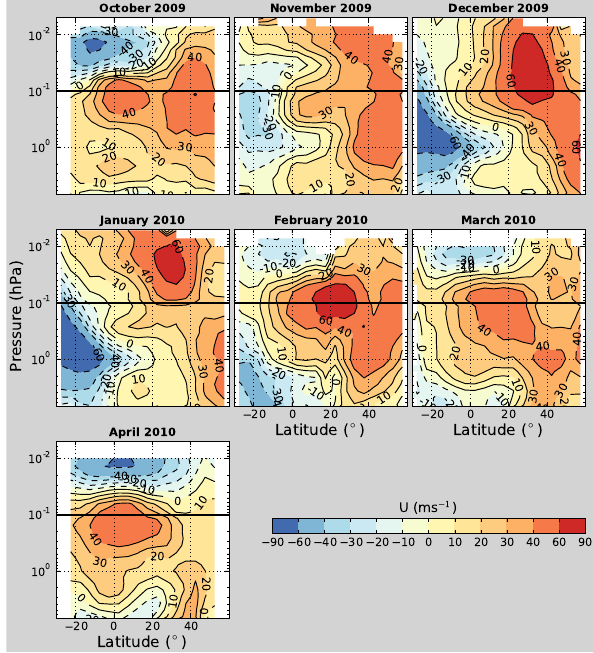
Fig. 10. Monthly and zonally averaged near zonal-wind derived from SMILES measurements in band B between October 2009 to April 2010. Wind information is taken from the O 3 line retrieval for altitudes below 0.1hPa (65km) and from the HCl line retrieval above. Data with a line-of-sight orientation between ± 10 ◦ from the zonal direction are